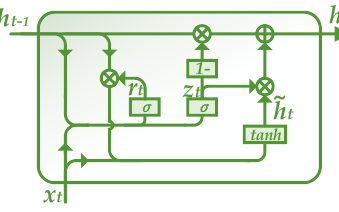
Figure 7. The structure of a gated recurrent unit (GRU) block.